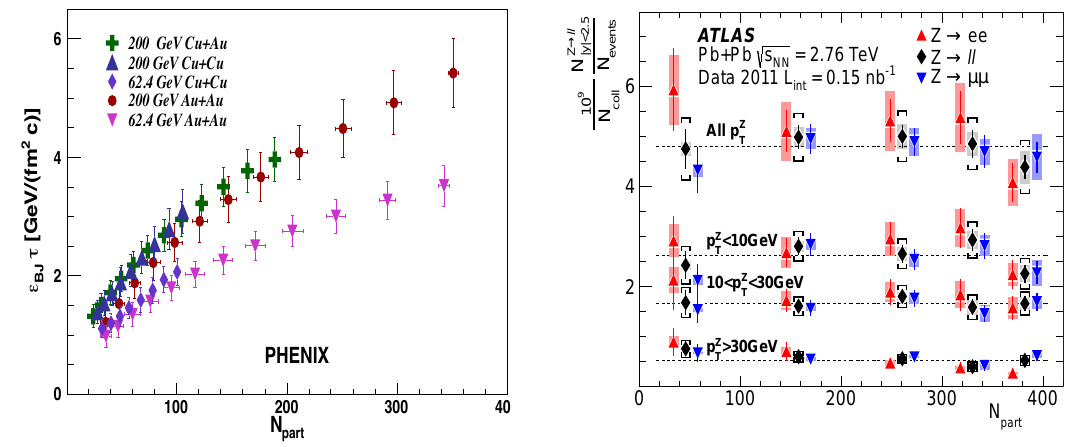
Figure 13. Left : The Bjorken estimate of the initial energy density ε BJ (Equation (32)) multiplied by the thermalization time τ as a function of N part for different colliding systems (Au + Au, Cu + Au, Cu + Cu) √ s at two energies ( = 62.4 and 200 GeV). Reproduced from Ref. [130]; Right : The dependence of Z NN boson yields divided by average number of collisions < N coll > on the average number of participants √ s < N part > for Pb + Pb collisions at = 2.76 TeV. Reproduced from Ref. NN